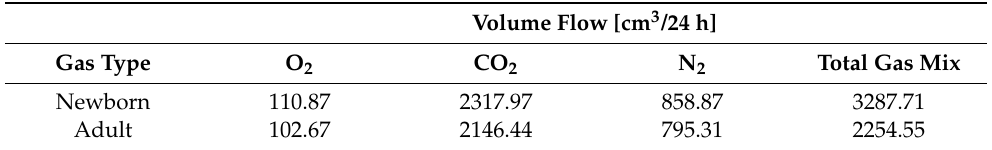
Table 2. Mean Volume Flow over 24 h for the real diffusion ( F* ) of respiratory gases from the Middle-ear cavities to the internal environment of the human